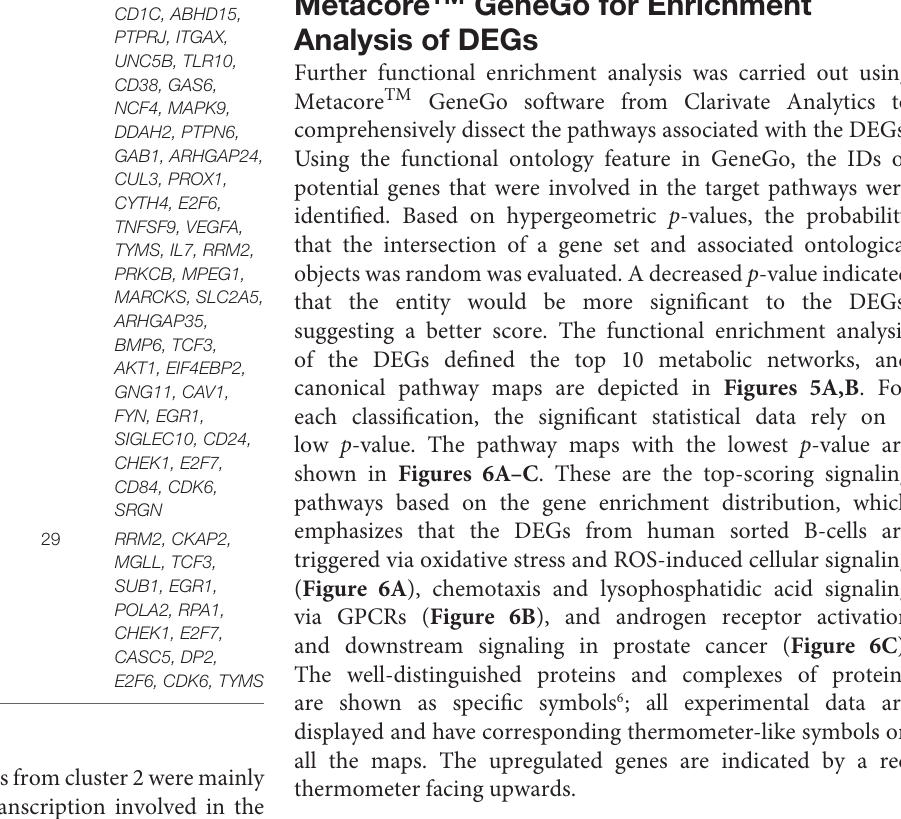
TABLE 3 | The interconnected regions are clustered from the GSE30153 dataset using MCODE plugin in Cytoscape. Cluster Score (density × Nodes Edges Node No. of nodes)